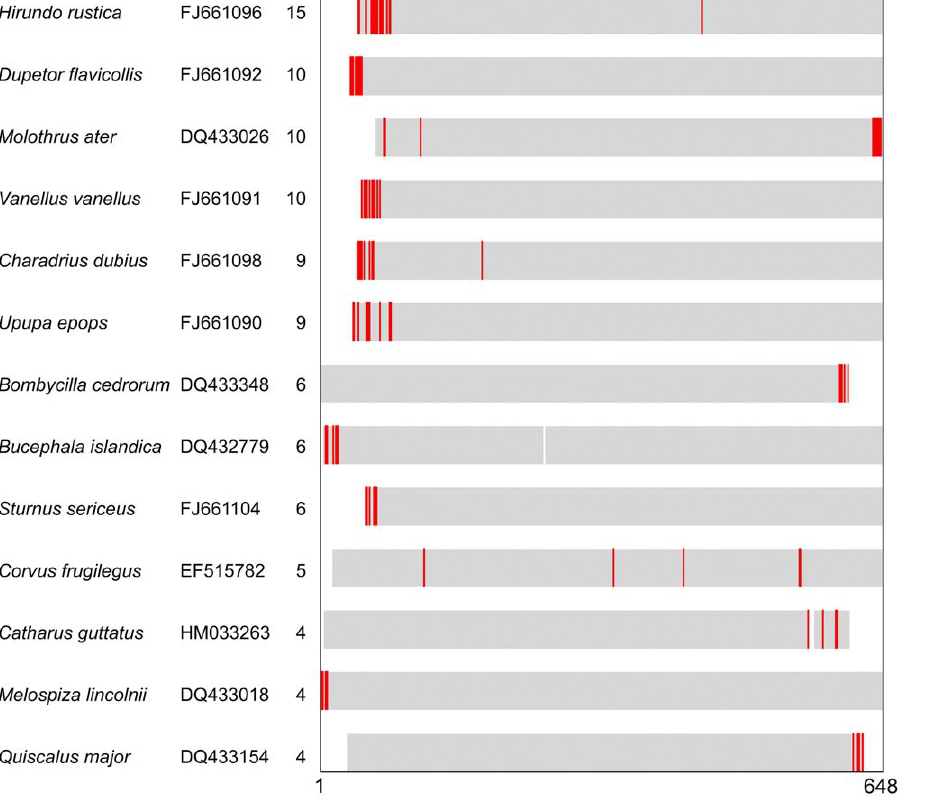
Figure 7. BARCODEs with four or more nucleotide singleton VLFs. Species name, GenBank accession number, and number of VLFs are shown. Gray bars indicate sequence alignment relative to 648 bp barcode region, VLFs are in red, and blanks indicate ambiguous positions. VLFs were concentrated at the 5 9 or 3 9 terminus, consistent with sequencing error, except for C. frugilegus EF515782, which appeared to be a pseudogene (Fig. S3).